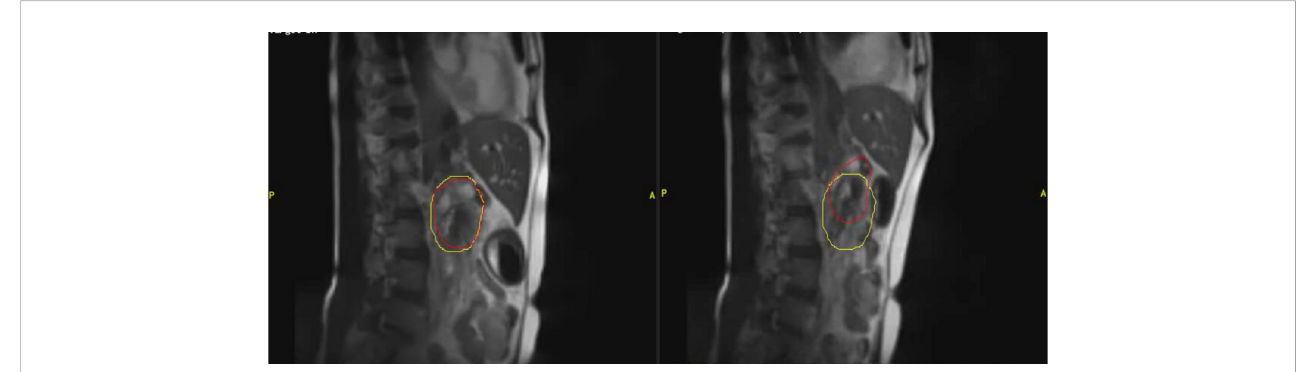
FIGURE 3 An example of clinical MRI-Linac images utilized for intra-fractional management. The panel on the left shows a patient receiving pancreatic radiotherapy while imaged with a deep inspiratory breathe hold. The panel of the right shows the same patient breathing freely. The red contour depicts the tracking contour and the yellow contour depicts the treatment envelope boundary.